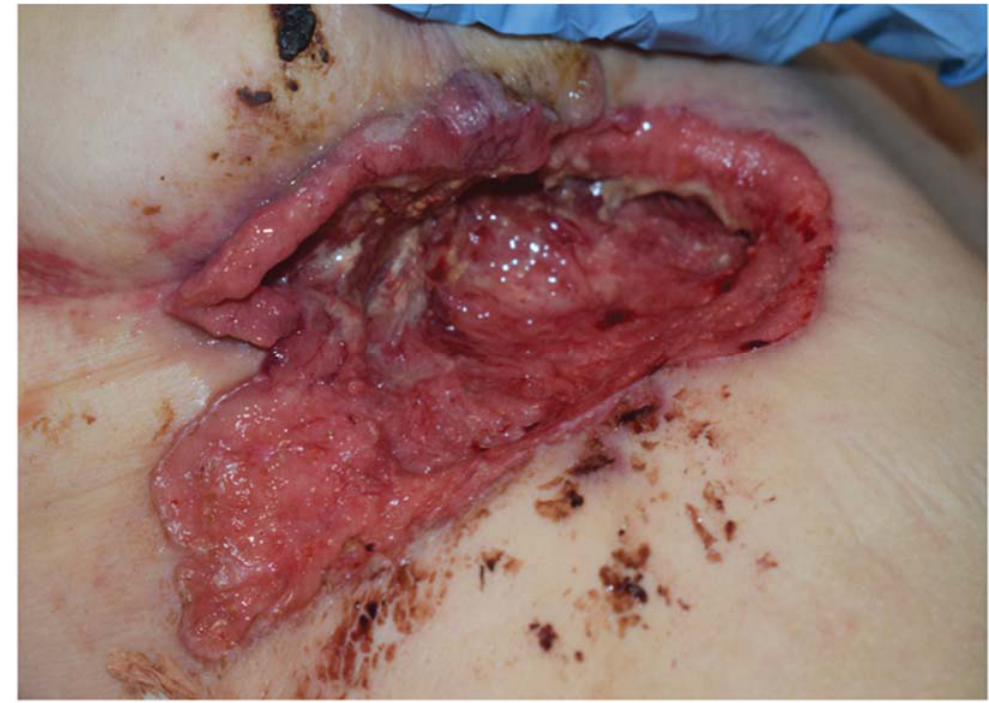
Figure 1. Ulcerative tumour. The picture shows a large infiltrating and ulcerative tumour inferior of the right breast.